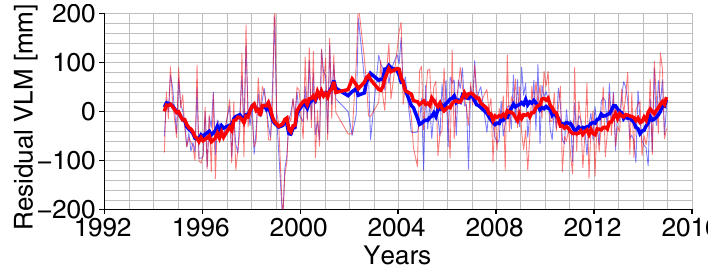
Figure 5. Time series of ALT–TG differenced VLM at the Llandudno (UK) TG. A moving-average filter is applied to visualize the interannual variability. In blue: with a threshold of 0.0 for the correlation, but without correlation weighting. In red: with a threshold of 0.0 for the correlation and with correlation weighting. In the background are the time series without a moving-average filter